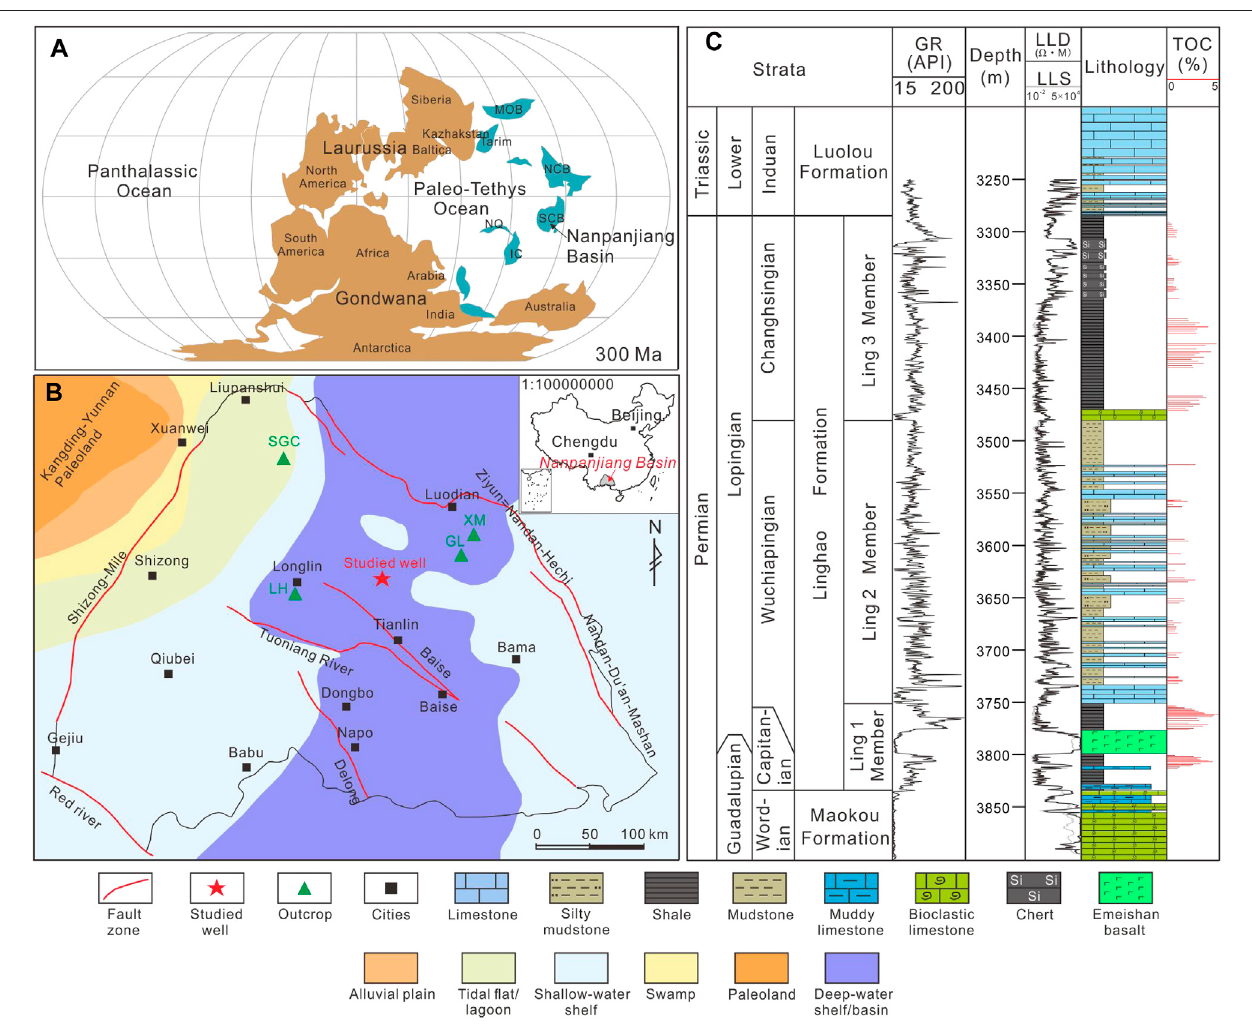
FIGURE1|(A) Paleogeographic reconstructions oftheEastern Asianblocksat 300 Mawithrespect totheNanpanjiangbasin. IC,MOB, NCB,NQ,Qm,and SCB represent the Indochina, Mongolian, North China, North Qiangtang, Qaidam, and South China blocks/terranes (modi fi ed from Huang et al., 2018). (B) Location of the Nanpanjiang basin, Southwest China (modi fi ed from Xia et al., 2018). (C) Generalized stratigraphy of Upper Permian Linghao Formation in the study area (based on the studied well).